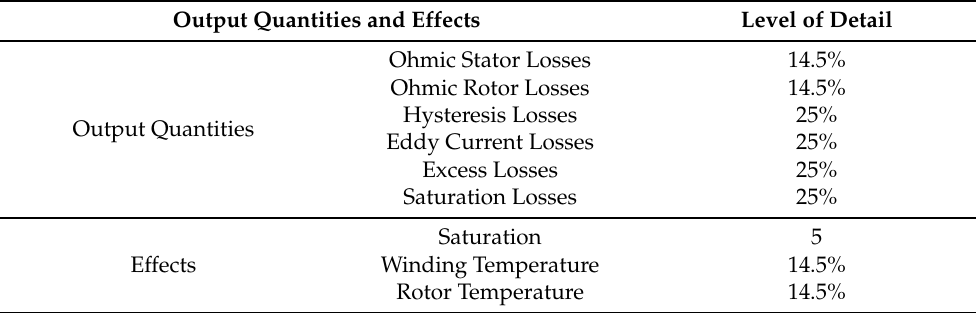
Table 1. Required level of detail of the output quantities and effects of the electromagnetic model.